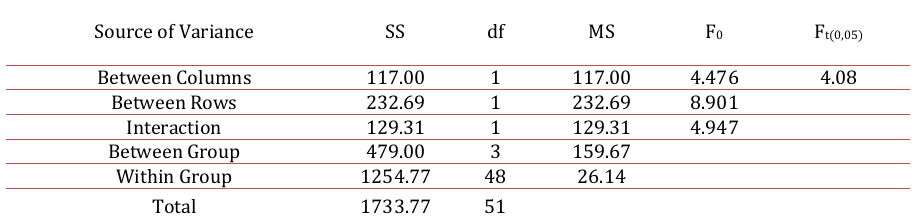
Table 3. The Summary of 2 x 2 Multifactor Analysis of Variance